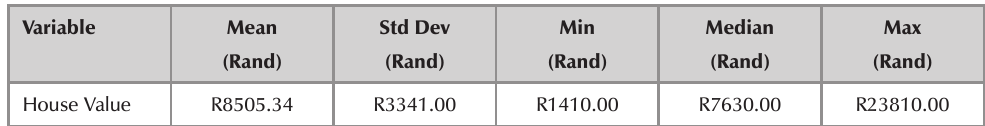
Analysis of the house value statistic in the hedonic price